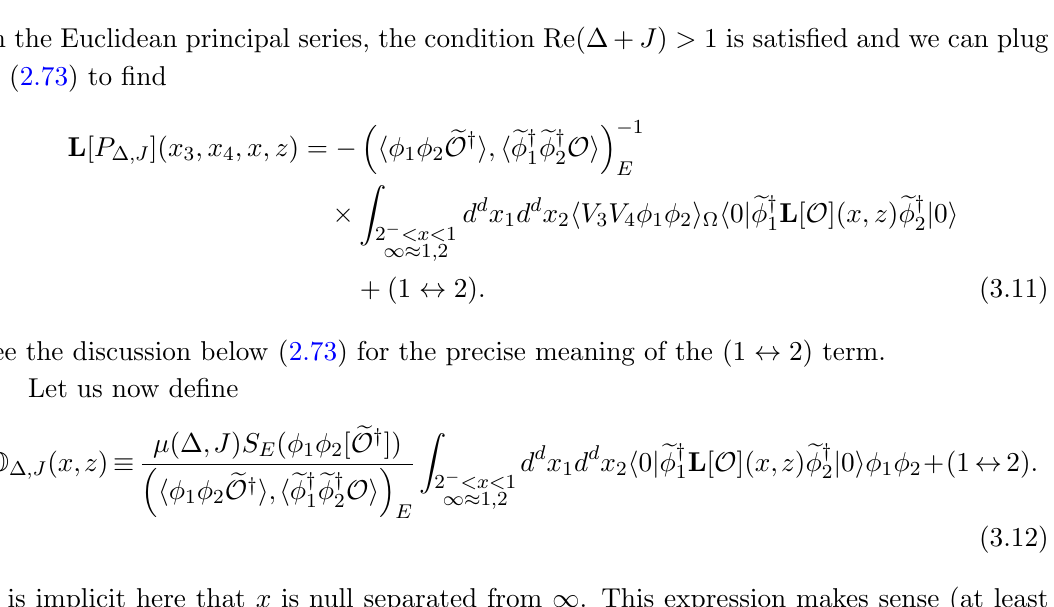
Figure 8. The con(cid:12)guration of points within the Poincare patch of 1 . Point 4 is in the future of x and 3 is in the past of x + , while x is null separated and in the past of 1 . The shaded yellow (red) region is the region of integration for 1 (2) after taking the light transform, in the (cid:12)rst term in equations (3.11) and (3.12). The dashed null line is spanned by z . Note that in (b), for d > 2 the region S extends in and out of the picture, while the dashed null line